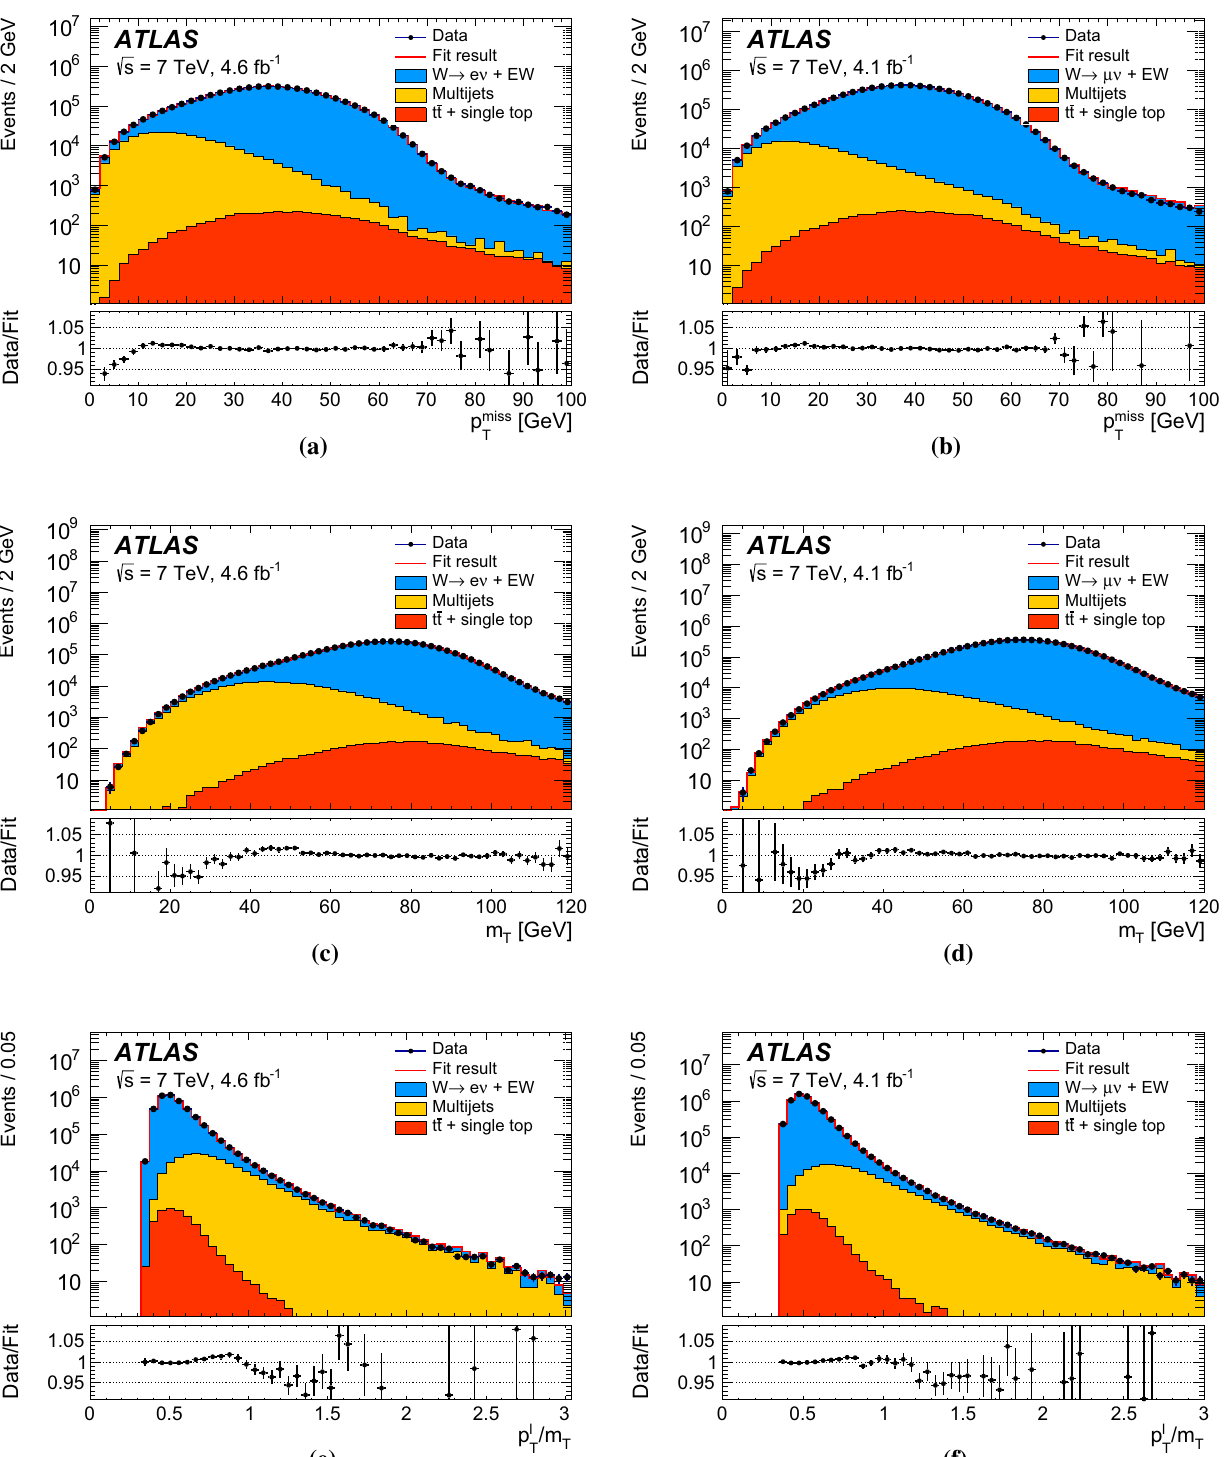
μ, cone / p (cid:7) < 0 . 4 in the muon channel. The data are com- and 0 . 2 < p T T pared to the simulation including signal and background